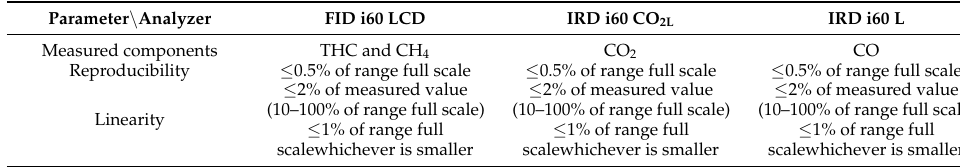
Table 2. Accuracy specifications of AMA i60 analysers. Parameter \ Analyzer